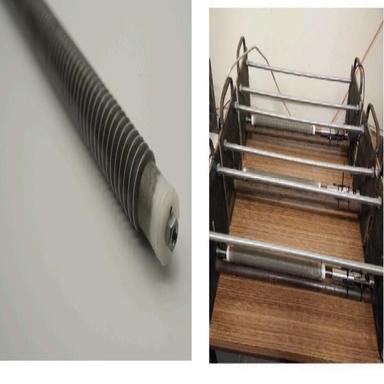
a) Corrugated moulds for autogenous shrinkage measurement: b) Autogenous shrinkage set-up.